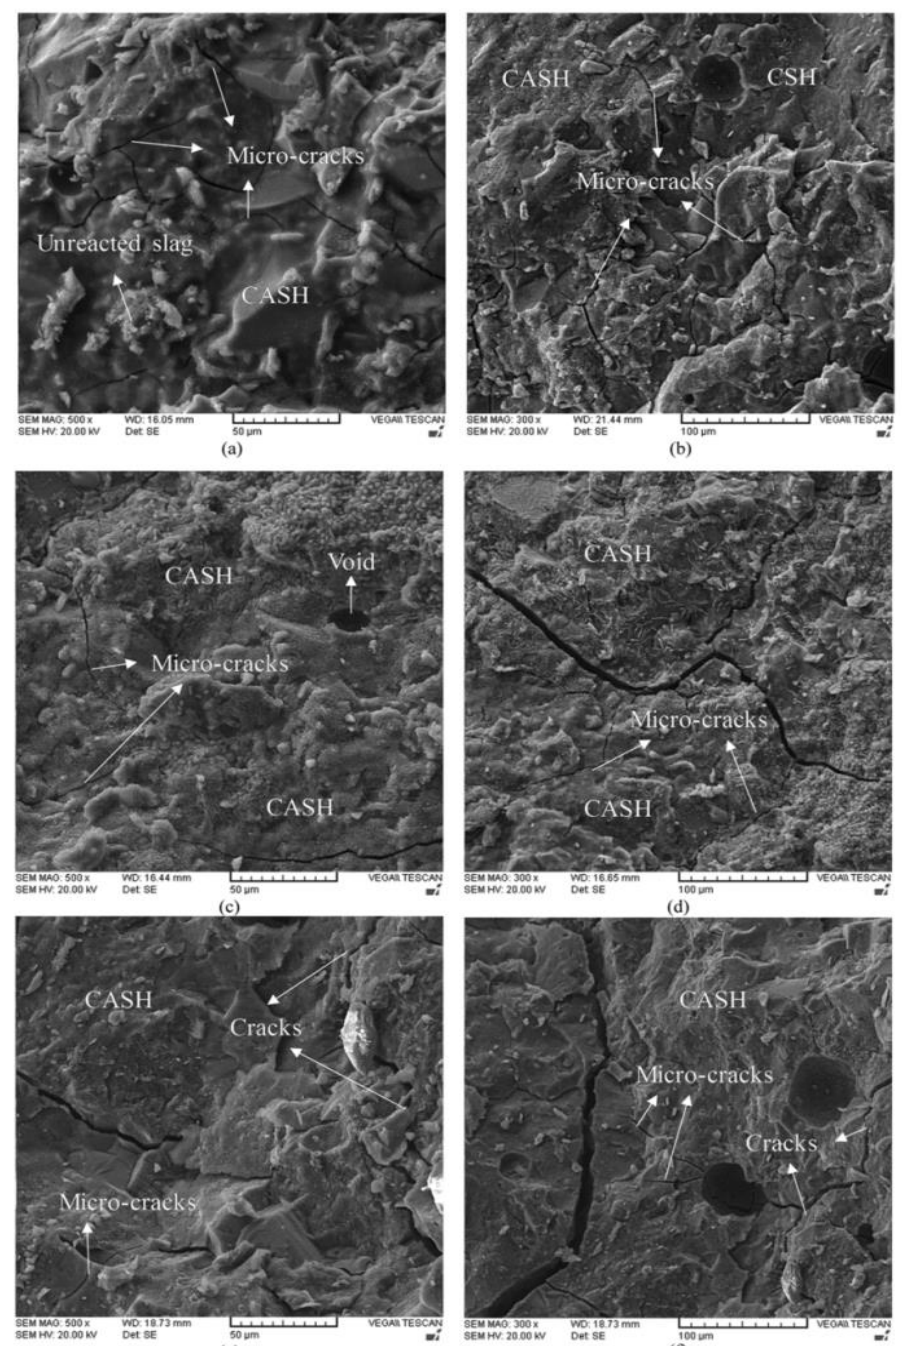
Figure 2. SEM images of AAS paste with various NaOH concentrations at different magnifications: ( a ) 8 M NaOH (500×), ( b ) 8 M NaOH (300×), ( c ) 12 M NaOH (500×), ( d ) 12 M NaOH (300×), ( e ) 16 M NaOH (500×) and ( f ) 16 M NaOH (300×) [123].